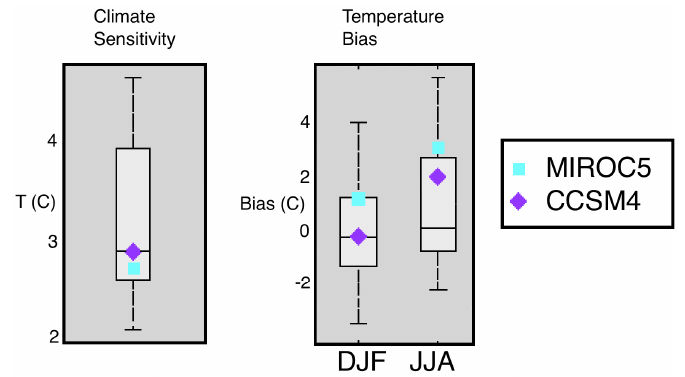
Figure 2. Performance assessment of the selected Global Climate Models (GCM) based on Central North America biases. Climate sensitivity based on [32] (left), and GCM mean temperature bias over North America during winter (DJF) and summer seasons (JJA) based on [33] (right).